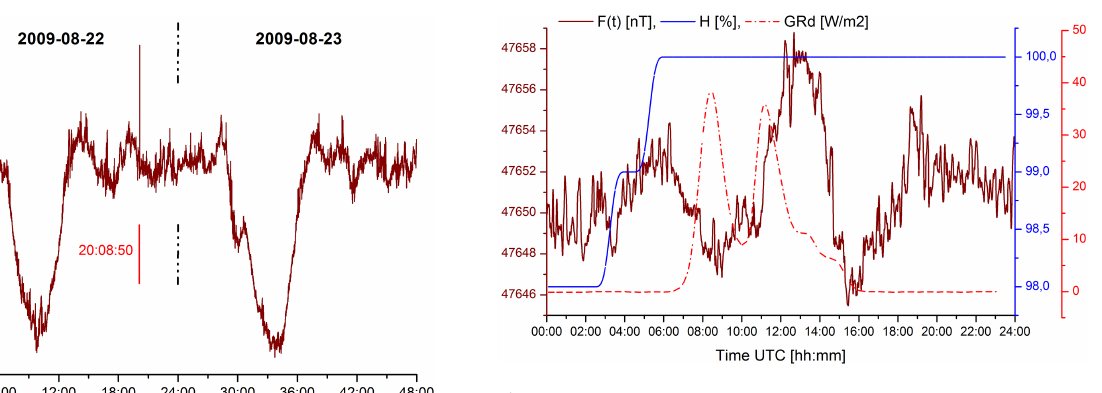
Figure 3. The local geomagnetic field’s variations at the Observa- tory for the 15 January 2013 snowstorm and the values of humid- ity ( H ) and solar radiation ( G Rd ) measured the same day at AMP Otlica.